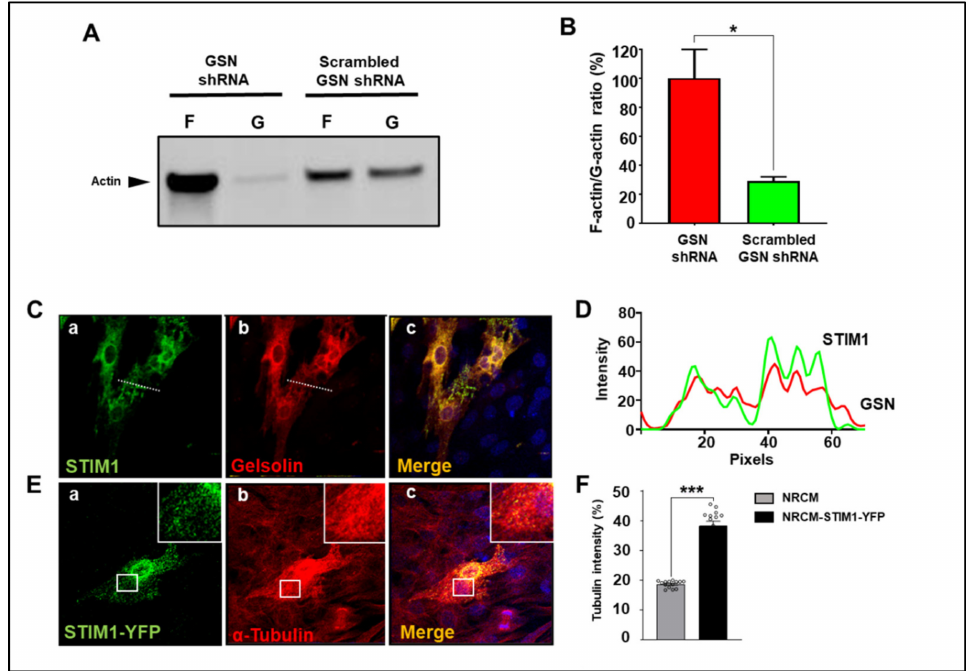
Figure 5. STIM1 induces cytoskeletal remodeling in NRCM. ( A ) Blot showing F- and G- actin in the STIM1 overexpressing NRCM. GSN knockdown cells there is accumulation of F-actin, in contrast to cells transfected with scrambled GSN shRNA. ( B ) Quantification analysis of F/G actin ratios. ( C ) NRCM transiently overexpressing STIM1-YFP (a) and co-stained with anti-GSN antibody (b) Merging the fluorescence signal reveals colocalization between STIM1 and GSN (c). ( D ) Line-scan profiles of fluorescence intensity for NRCM (form C , a and b). The green line indicates STIM1 spatial distribution, and the red line indicates GSN distribution. ( E ) Micrographs of NRCM transiently expressing STIM1-YFP (a) and stained with anti-tubulin antibody (b), merged channels (c). ( F ) Tubulin quantification by fluorescence intensity between NRCM and NRCM expressing STIM1-YFP. Data are from three independent experiments, * p < 0.05, *** p <